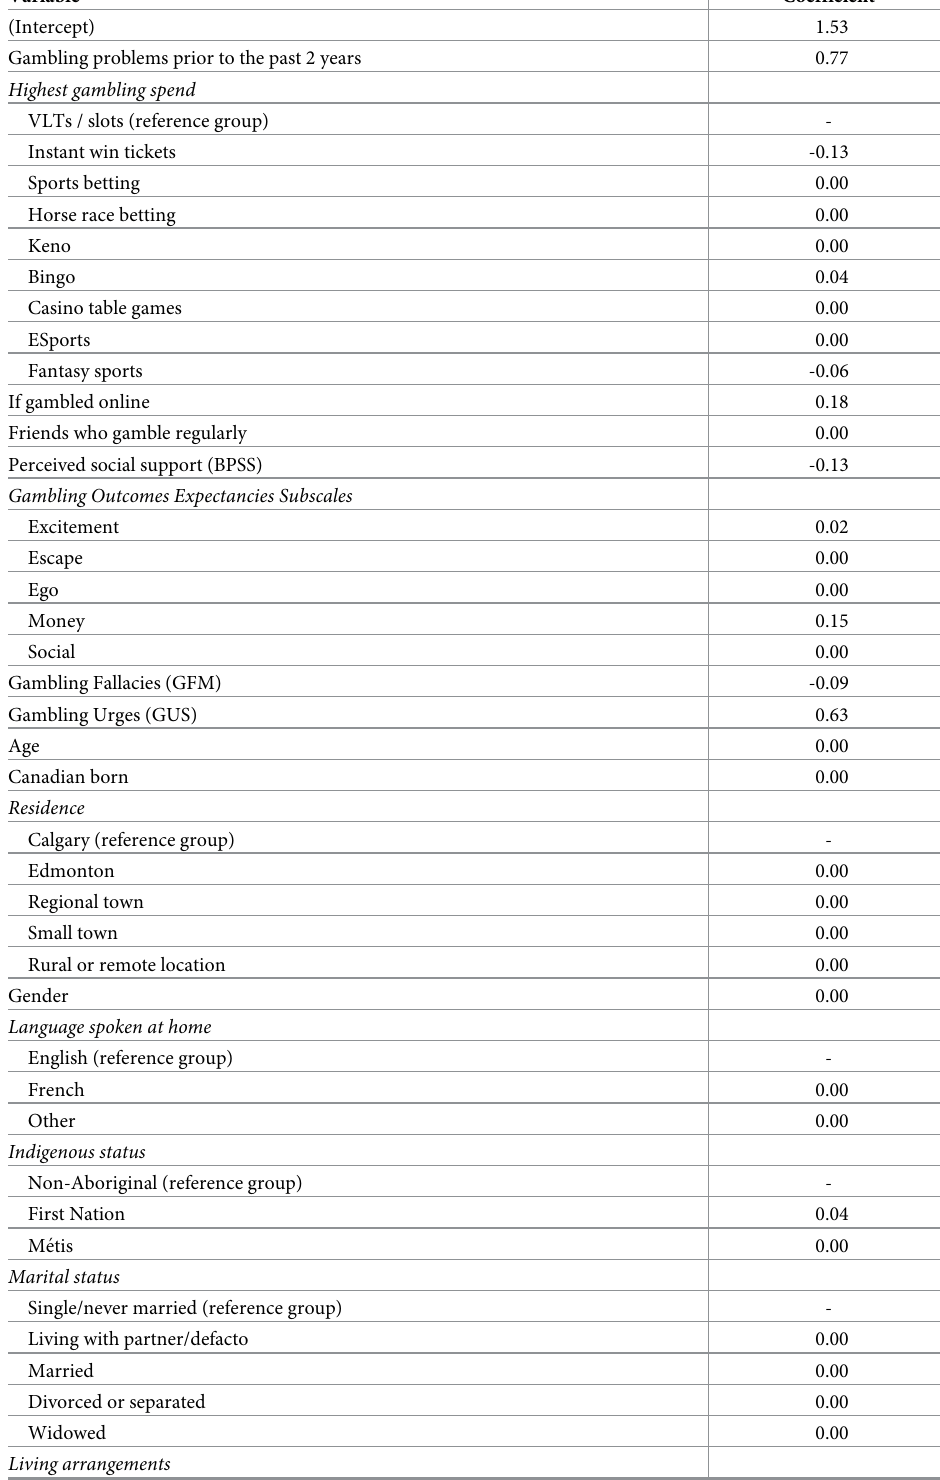
Table 2. Standardised elastic net regression coefficients predicting harm from all risk